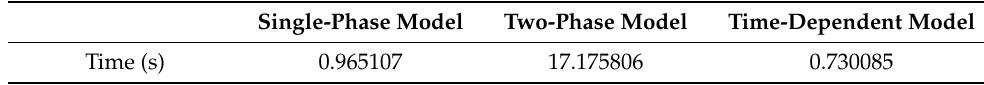
Table 3. The CPU time for each